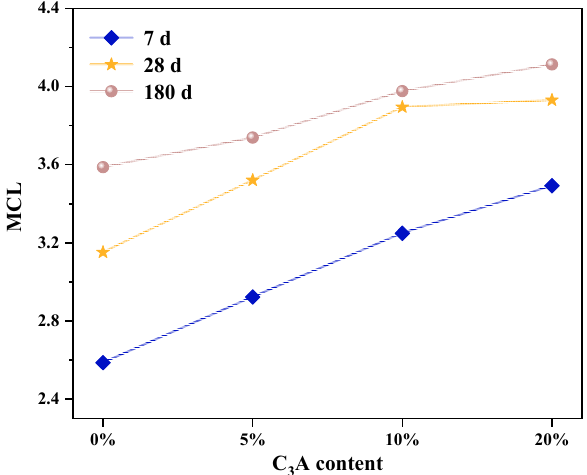
Figure 4. MCL variation of C-S-H gel in C 3 S-C 3 A paste under sulfate attack.